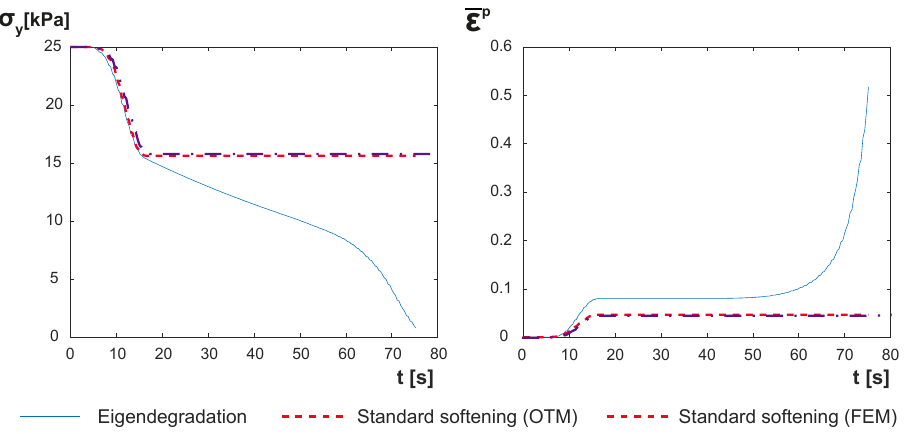
Figure 13. Evolution of the shear strength and the equivalent plastic strain along the time for both eigendegradation and softening